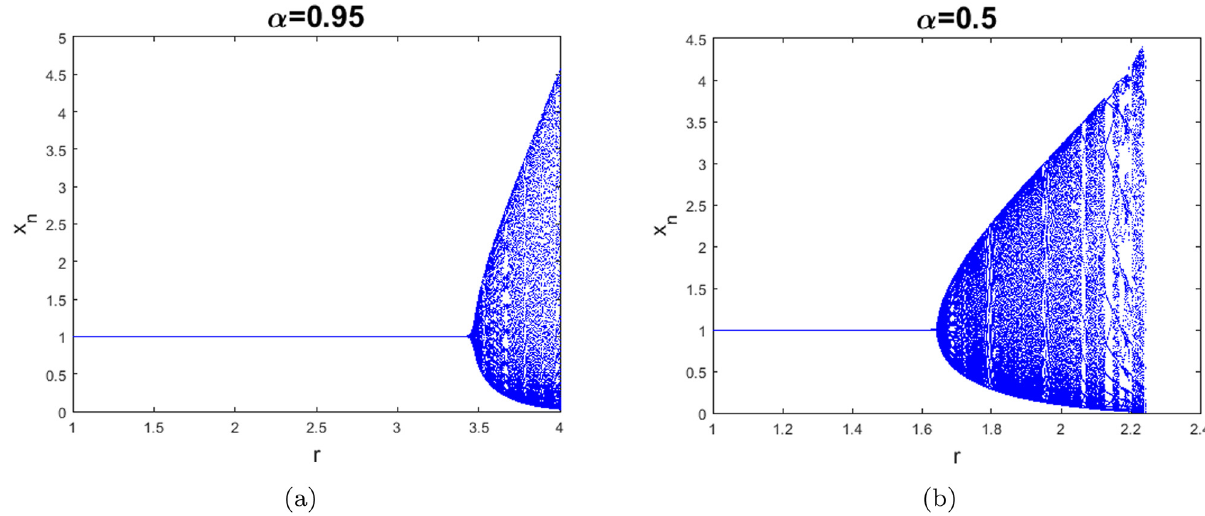
Figure 5: Bifurcation diagram of system ( 8 ) as a function of r for the parameters = = p q 0.5,